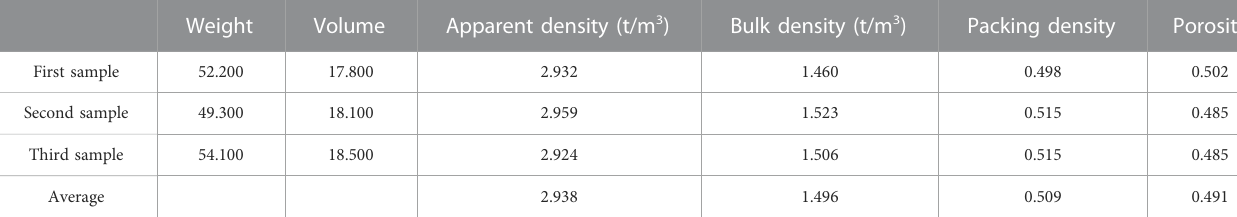
TABLE 1 Basic physical parameters of unclassi fi ed tailings.